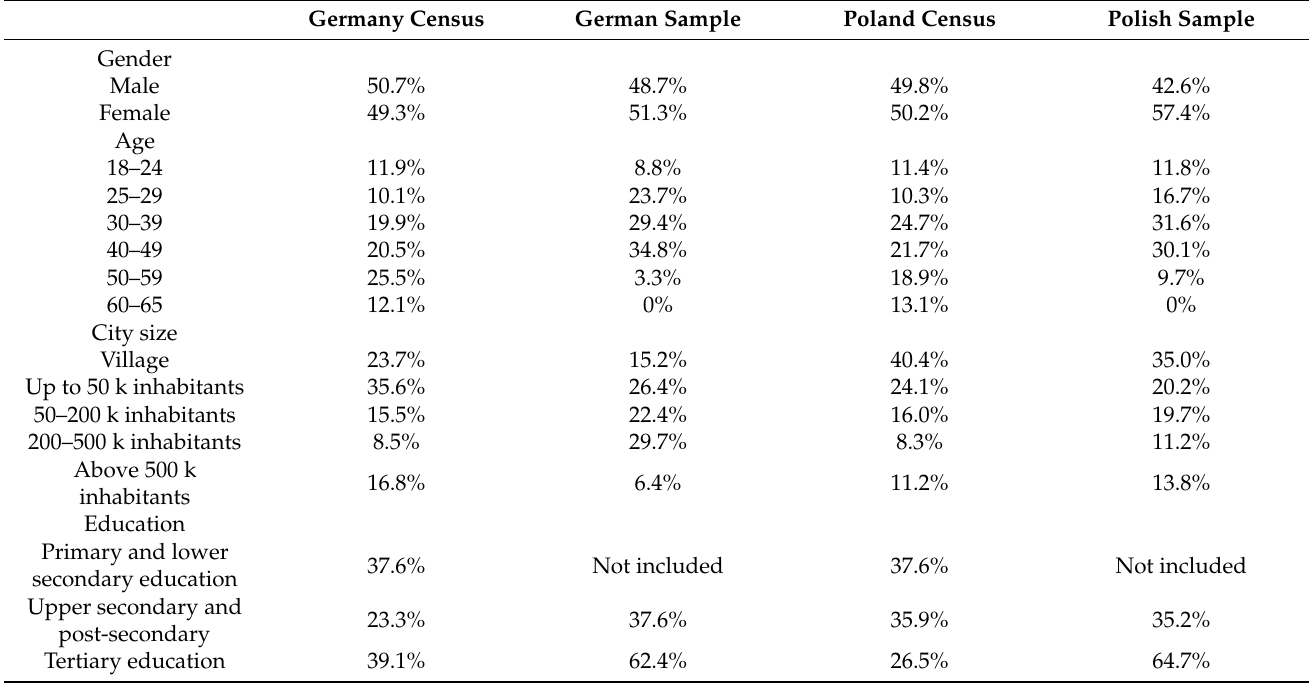
Table 1. Structure of the sample compared to census data